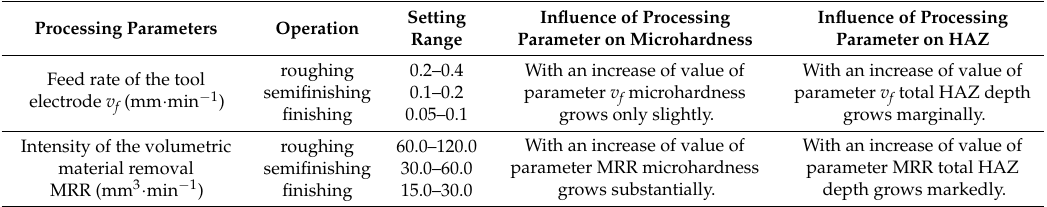
Table 2. Setting range of process parameters at die-sinking EDM with a SF-Cu electrode of φ 20 mm diameter, and their expected impact on microhardness change and total HAZ